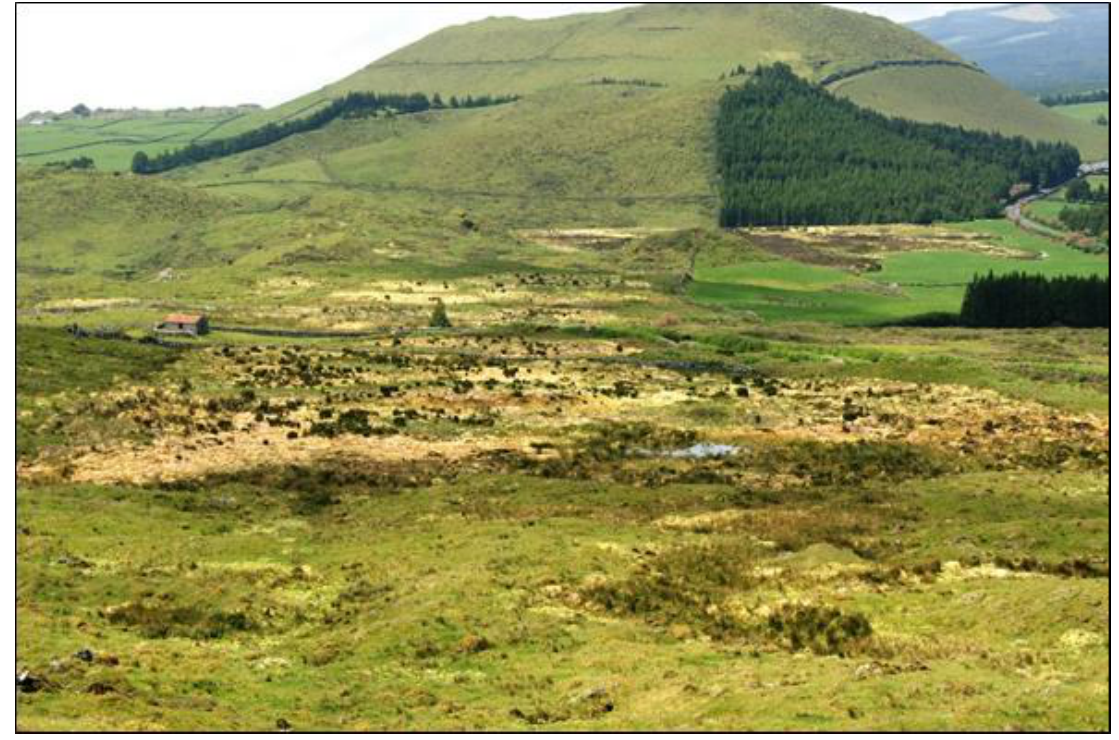
Figure 2. Typical landscape with peat bogs in the interior part of Terceira